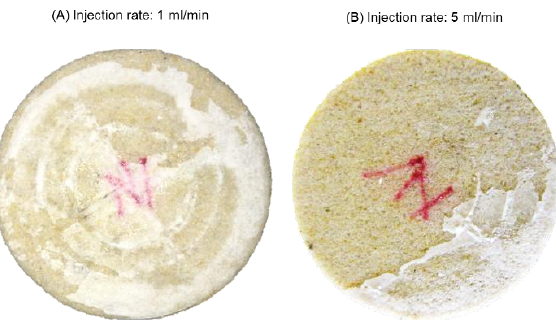
Figure 3. Pictures showing salt precipitation on the core inlet when supercritical CO 2 injection rate was increased from ( a ) 1 mL/min to ( b ) 5 mL/min. Increase in CO 2 injection rate decreased the amount of deposited salt.